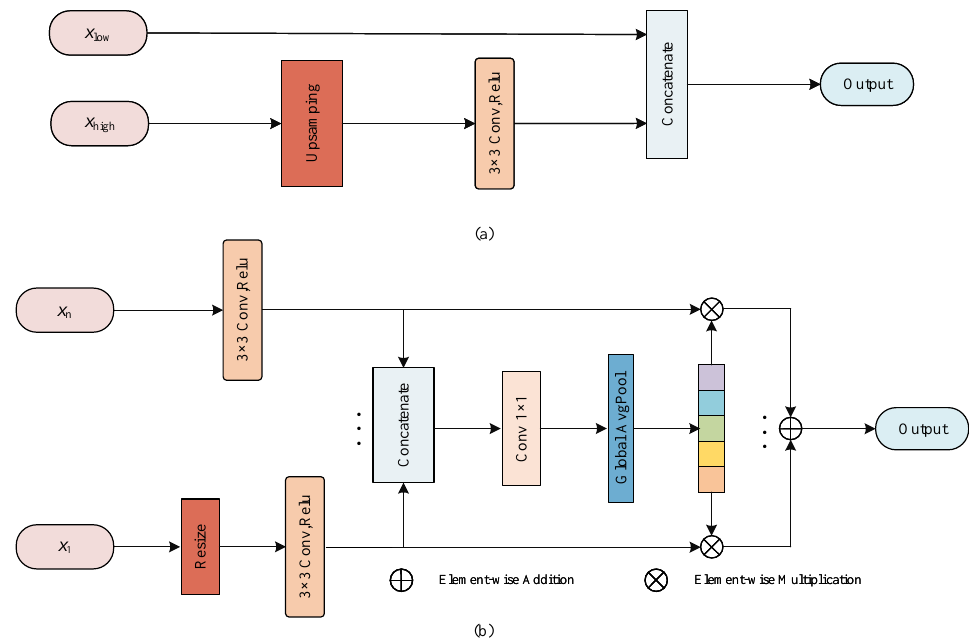
Figure 3. The illustration of proposed MF block. ( a ) The fusion scheme in U-Net; ( b ) The multi-scale fusion